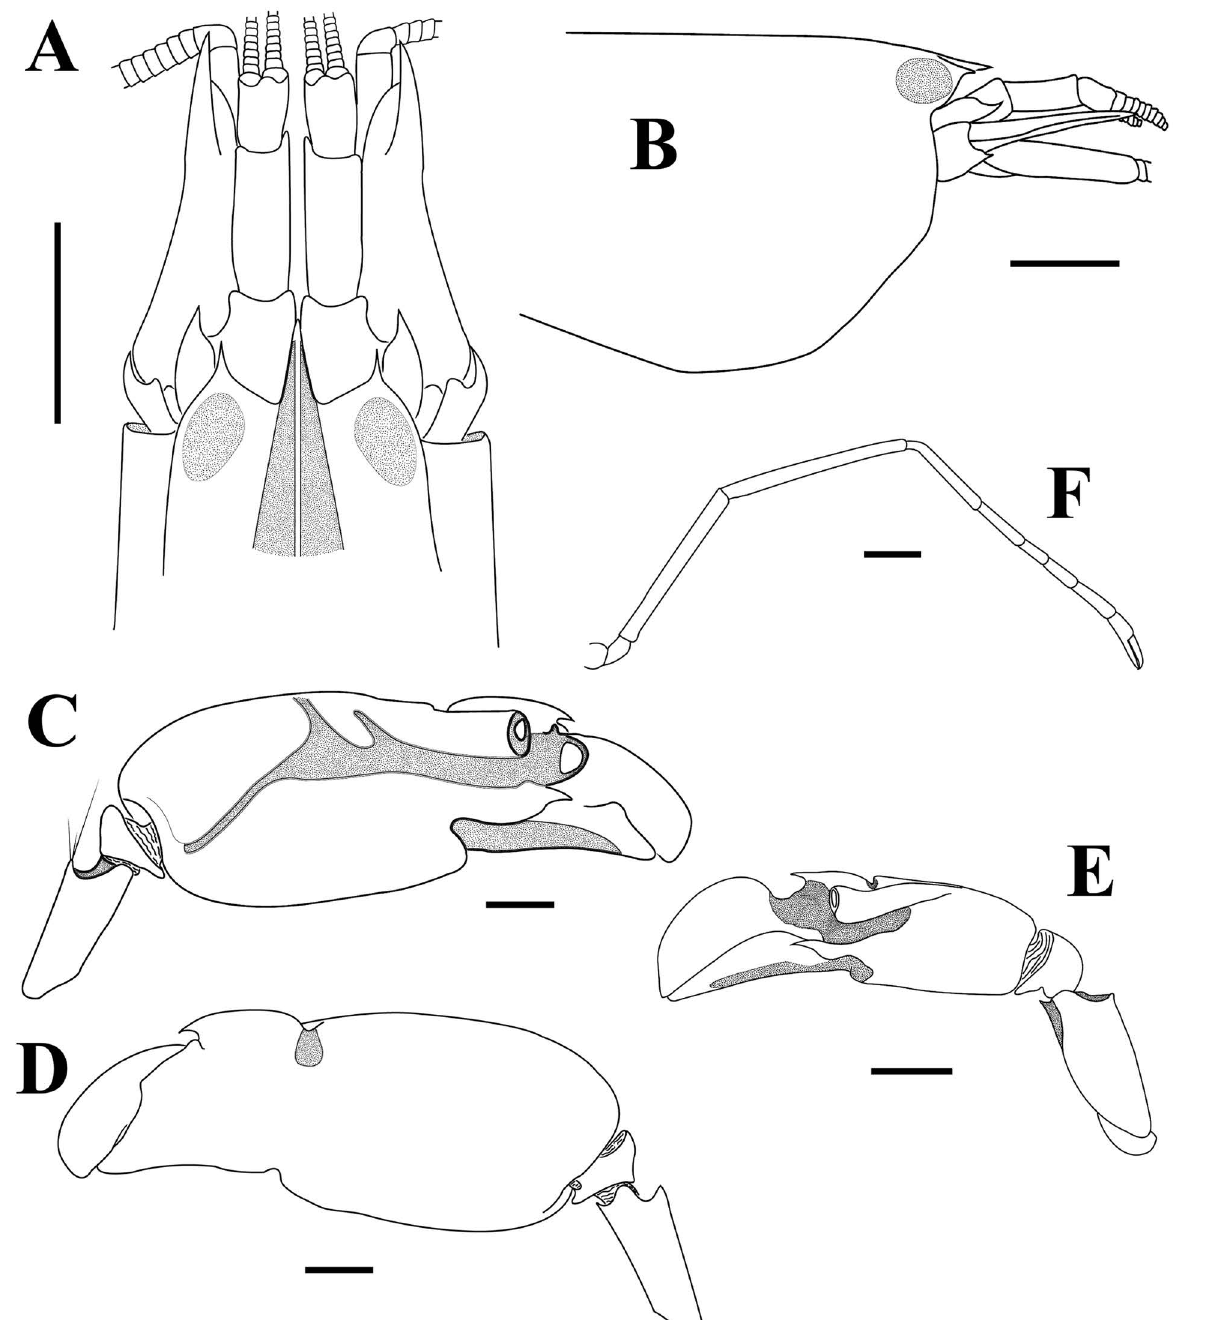
Figure 2. Alpheus pouang Christoffersen, 1979. Male from Canopus Expedition, Station 100 (05°55’S 34°58’W), Rio Grande do Norte, Brazil (MOUFPE 15317). A, frontal region and cephalic appendages, dorsal view (setae partially omitted); B, same, lateral view (setae partially omitted); C, major cheliped, lateral view (setae omitted); D, major cheliped, mesial view; E, minor cheliped, lateral view; F, second pereiopod. Scale bars = 1